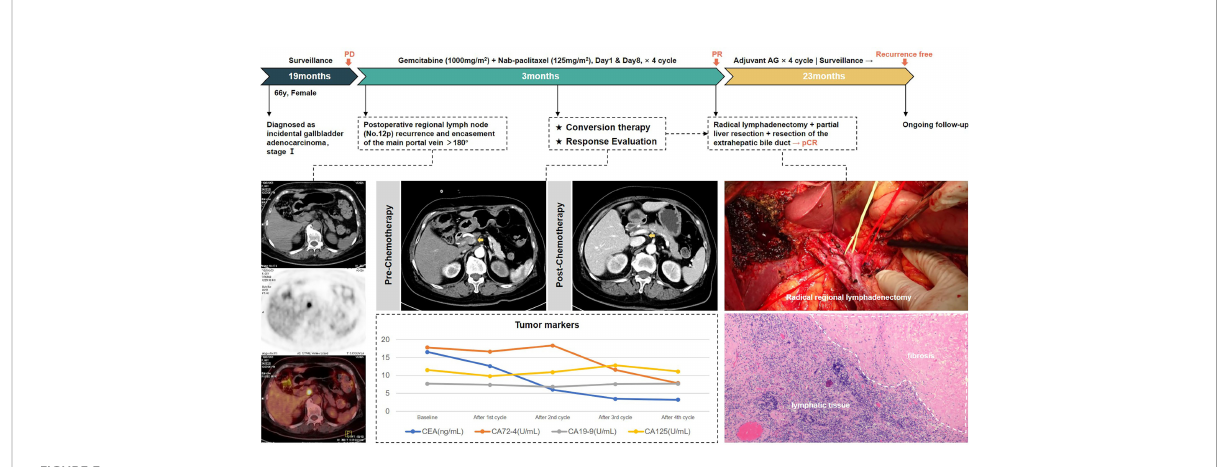
FIGURE 3 The treatment process of patient